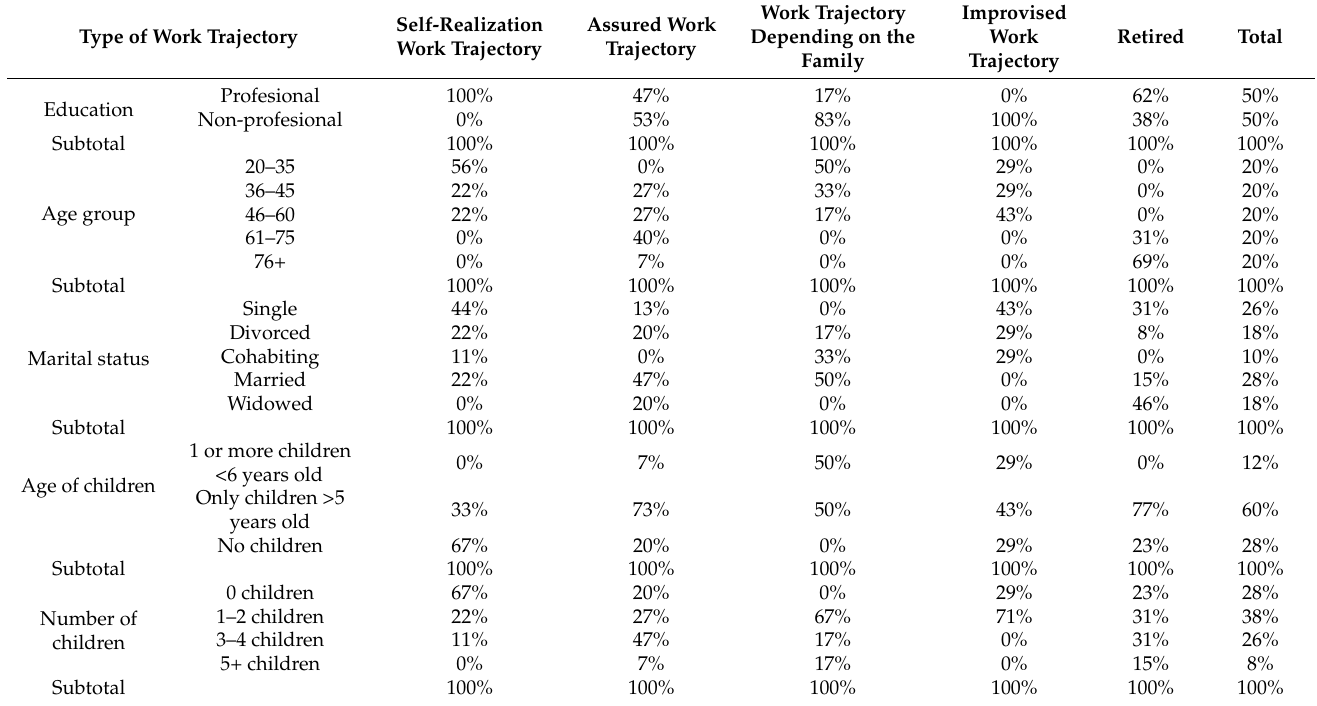
Table 3. Distribution (%) of age, educational attainment, marital status, and motherhood situation in each type of work trajectory. Type of Work